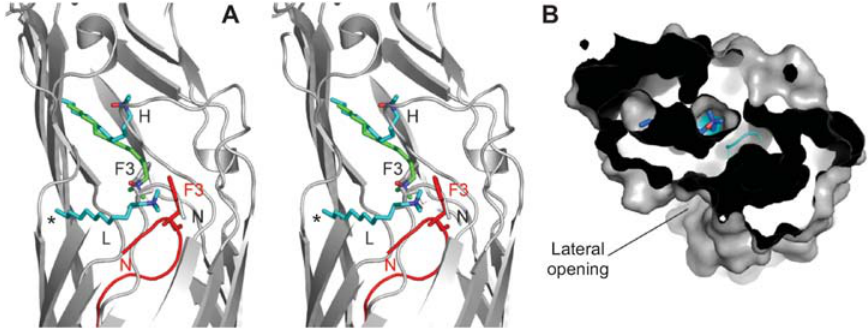
Figure 3 Conformational changes within the N-terminus of E. coli FadL. (A) Stereoview from the side, showing the different conformation of the N-terminus in monoclinic FadL and hexagonal FadL (red). Residue Phe3 is shown as a stick model and labeled. The detergent molecules present in monoclinic FadL are colored cyan (H, high-affinity binding site; L, lateral opening), and that in hexagonal FadL is colored green. The lateral opening is indicated with an asterisk. (B) Surface cut- away view of monoclinic FadL from the extracellular side, showing the interruption of the hydrophobic tunnel by the N-terminus of FadL (cyan). The detergent molecule in the high-affinity binding site is